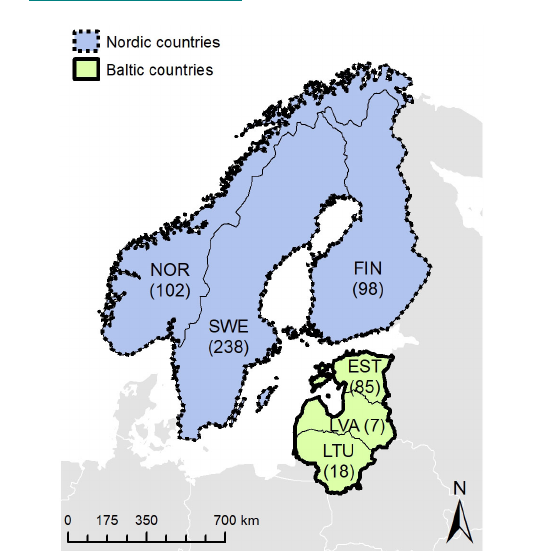
Fig. 2 . Map of the study region, showing the division into Nordic and Baltic countries and the number of reviewed articles per country (in parentheses). Country names are abbreviated as follows: NOR: Norway, SWE: Sweden, FIN: Finland, EST: Estonia, LVA: Latvia, and LTU: Lithuania. Administrative units from the European Commission, Eurostats, 2016. https://ec. europa.eu/eurostat/web/gisco/geodata/reference- data/administrative-units-statistical-units/ countries#countries16